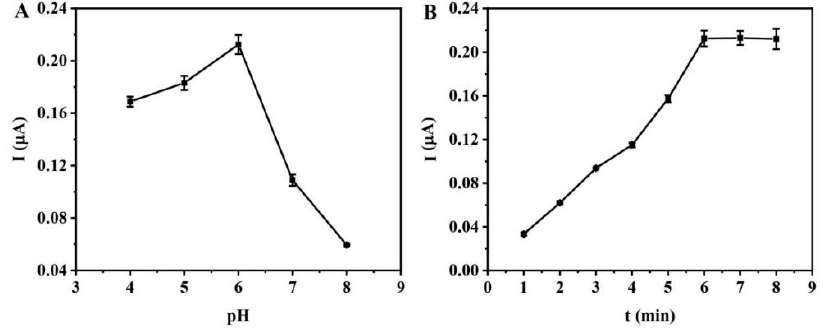
Figure 6. The influence of test solution pH ( A ) and incubation time ( B ) on DPV peak currents at poly([V 2 C 4 (mim) 2 ]Br 2 )/GCE after incubating in 2 μ M 4-NP in phosphate buffer.